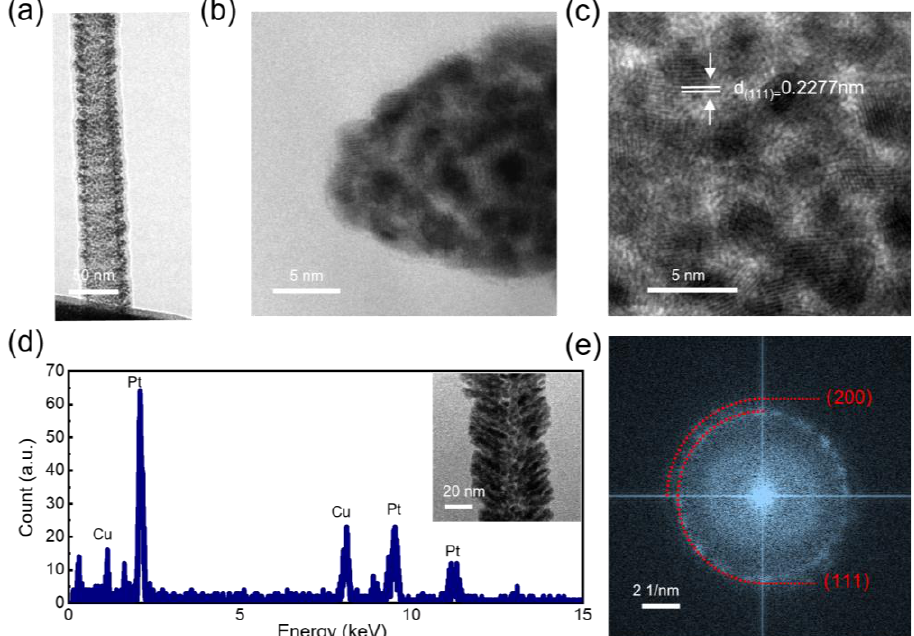
Figure 6. Characterization of the hybrid nanowire with the Pt shell. ( a ) TEM image on the side view of the nanowire, small Pt particles can be found on the surface of the MWCNT; ( b ) A TEM image of the tip of the as-prepared Pt shell; ( c ) high-resolution TEM image of the Pt particles on the tip with the characteristic lattice plane of (111) marked; ( d ) EDX spectrum of the Pt shell, the signals of copper (Cu) originating from the Cu grid for sample carrying; ( e ) FFT image of ( c ), with the polycrystalline rings of (111) and (200) marked.